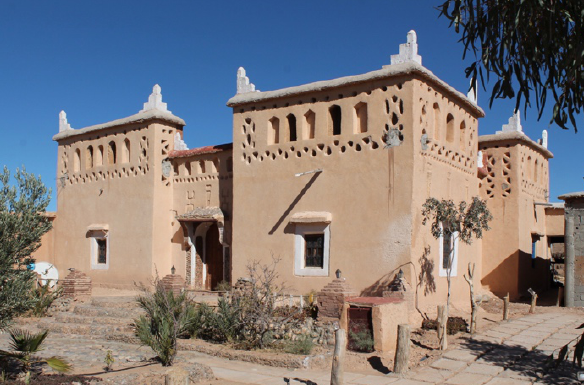
Figure 16. “Dar Timitar Vallée des Roses”,